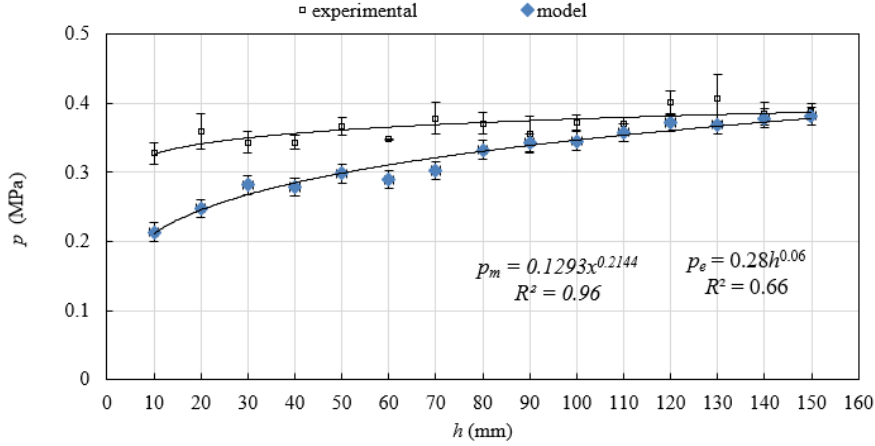
Figure 9. Influence of drop height on the experimental and model values of surface pressure, for concrete type substrates. pm — means model surface pressure, pe — means experimental surface pressure. Error bars represent mean ± SD (standard deviation).